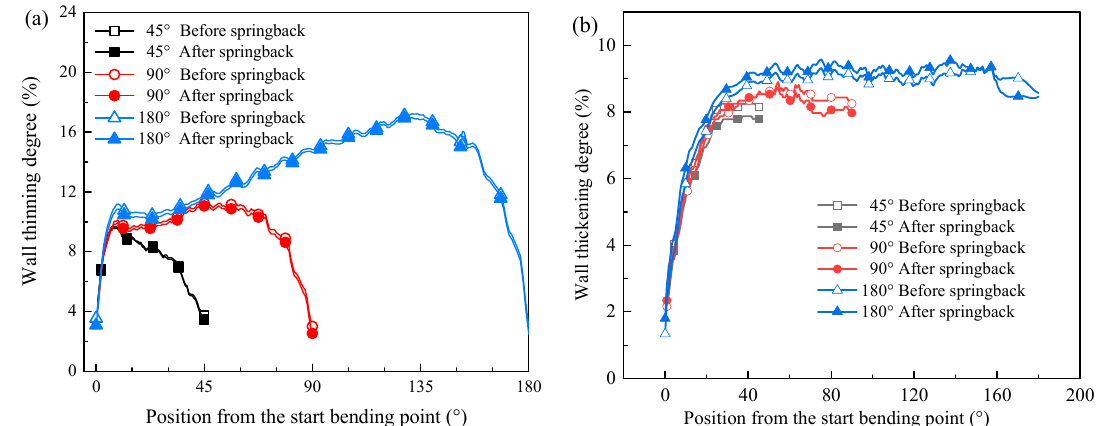
Figure 11. Variation of wall thickness variation under different bending angles at 250 °C: ( a ) thinning of extrados; ( b ) thickening of intrados.